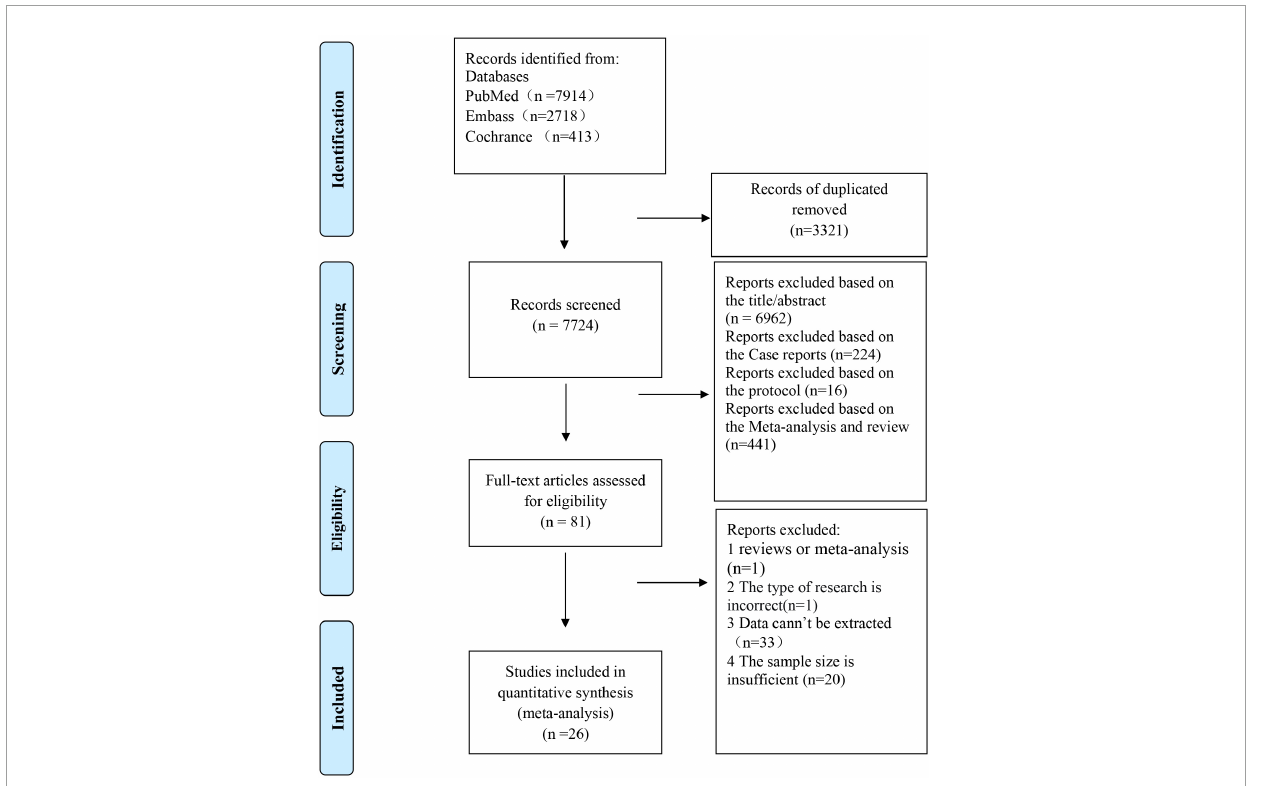
FIGURE1 Flowchart of the study selection for the meta-analysis of an association between periodontal disease and cardiovascular disease [adapted from Moher et al.